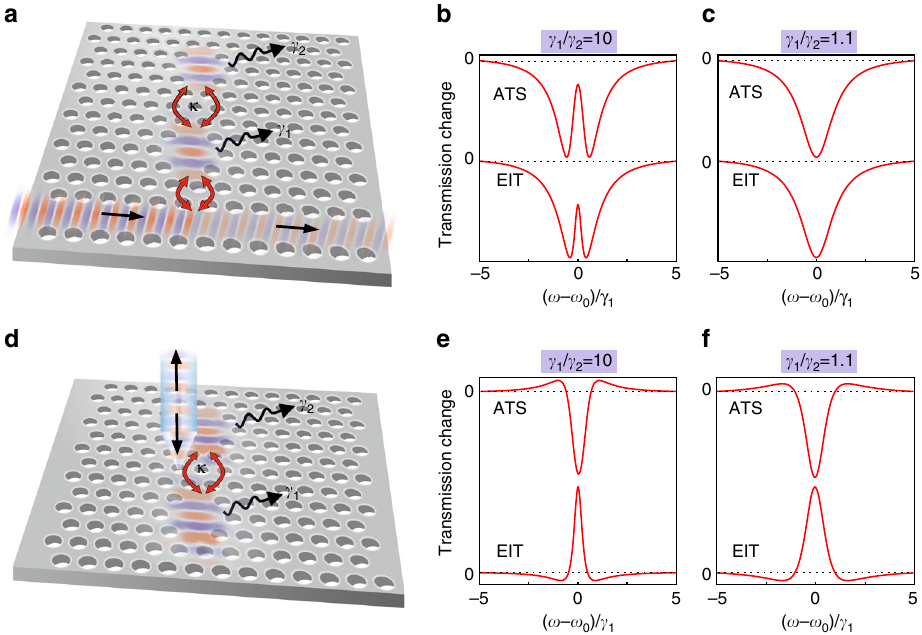
Fig. 1 Modeling of waveguide and near- fi eld resonant transmission in a photonic molecule close to the exceptional point. a Schematics of two coupled- photonic cavities tested by a waveguide, where the e.m. fi eld is propagating from left to right. The waveguide is coupled (red arrows) to the resonator with losses γ 1 , which is also coupled with coupling strength κ to the upper resonator with losses γ 2 . b , c Calculated waveguide transmission change due to the presence of the photonic molecule for different values of κ to reproduce both the Autler – Townes splitting (ATS) case, for κ = 1.2 κ 0 , and the electromagnetic-induced transparency (EIT) case, for κ = 0.8 κ 0 , with γ 1 / γ 2 = 10 and γ 1 / γ 2 = 1.1, respectively. The resonant frequencies of the single uncoupled cavities are ω 1 = ω 2 = ω 0 . d Schematics of the photonic molecule tested by a near- fi eld probe (blue cone) with incoming and outgoing e.m. waves. e , f Calculated transmission change through the near- fi eld probe for the same cases reported in b and c , respectively. All spectra are calculated by means of the coupled-mode theory (Supplementary Note 4). Horizontal dashed lines represent the zero value of each lineshape